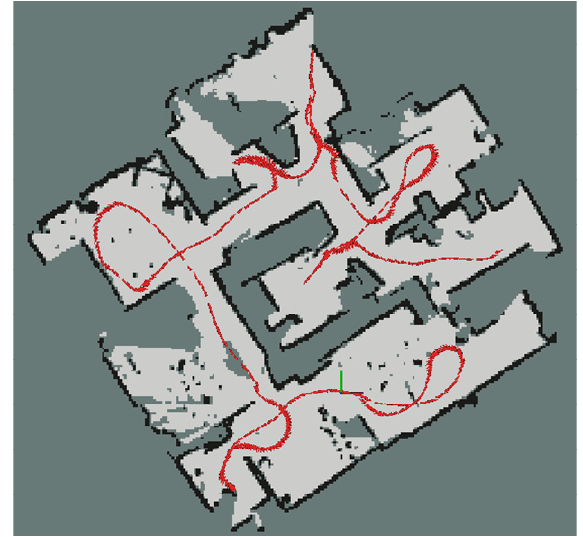
Figure 2. Occupied grid map and robot trajectory generated by Cartographer.